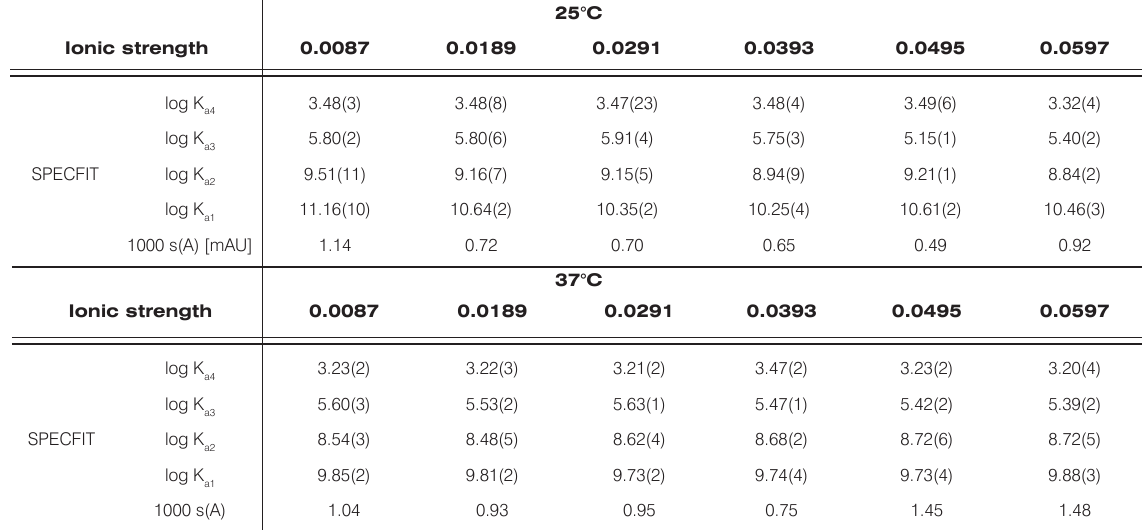
constants of vardenafil at 25°C and 37°C and various values of an ionic strength estimated by non-linear regression using programs SPECFIT. Standard deviations of protonation constants in the last valid digits are in parentheses, s ( A ) is the calculated standard deviation of absorbance in milli absorbance units when regression process terminates.